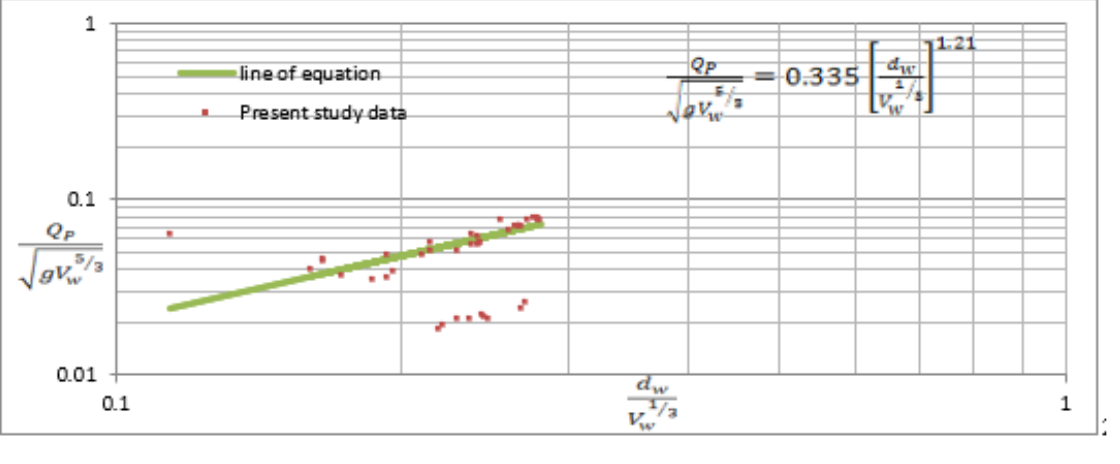
Figure 7. Variation